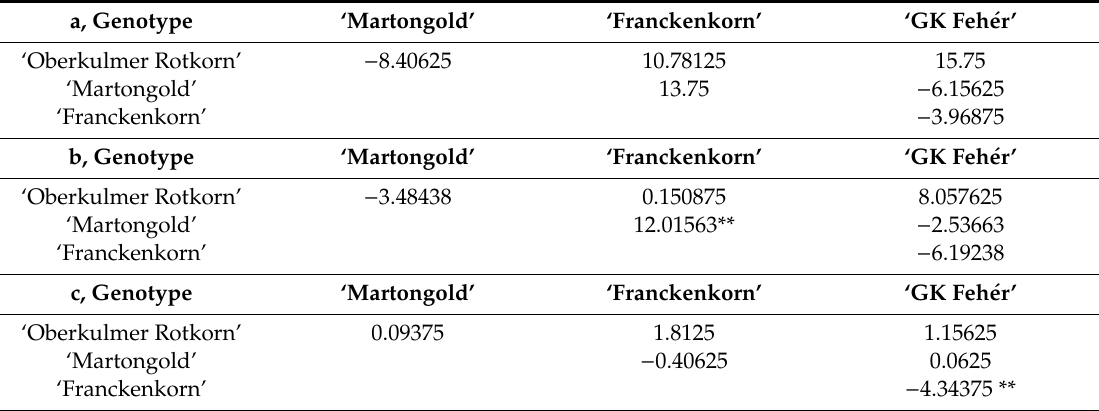
Table 7. Specific combining ability (SCA) e ff ects for ( a ) embryoid, ( b ) green-, and ( c ) albino plantlets. a,